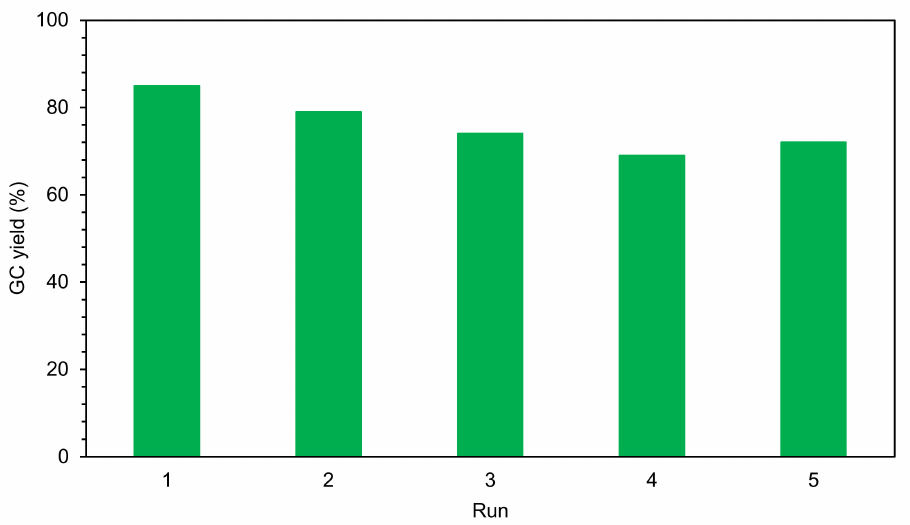
Figure 15. Recyclability test for the Cu 1 Ce 0.7 Si